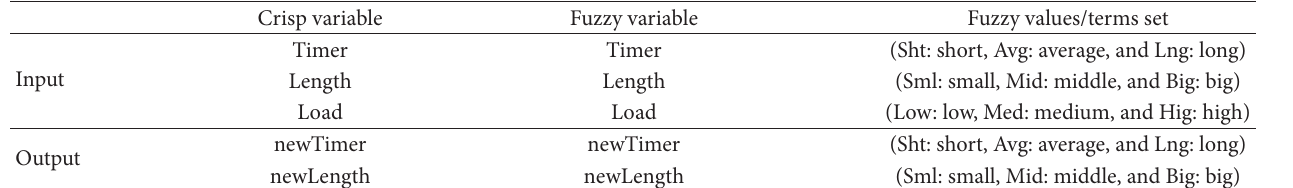
Table 1: Crisp and fuzzy input and output variables.